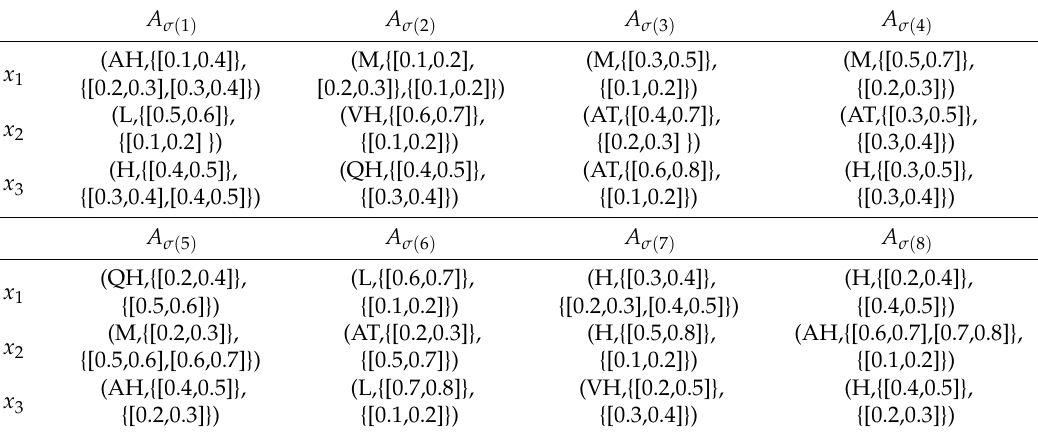
Table 6. The prioritized individual IVDHFUBL decision matrix R 2